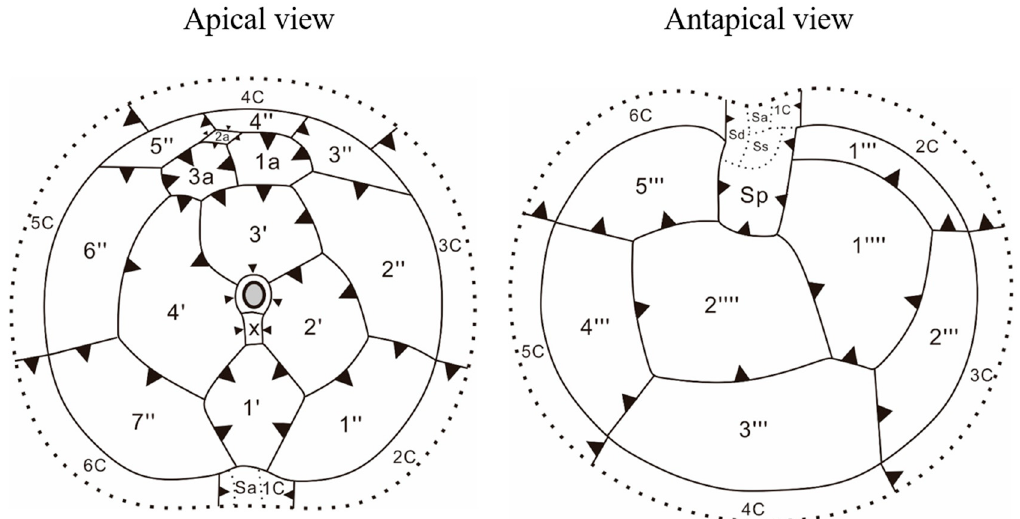
Figure 5. Schematic drawings of thecal plate patterns of Scrippsiella precaria. Arrowheads indicate the plate overlap pattern.